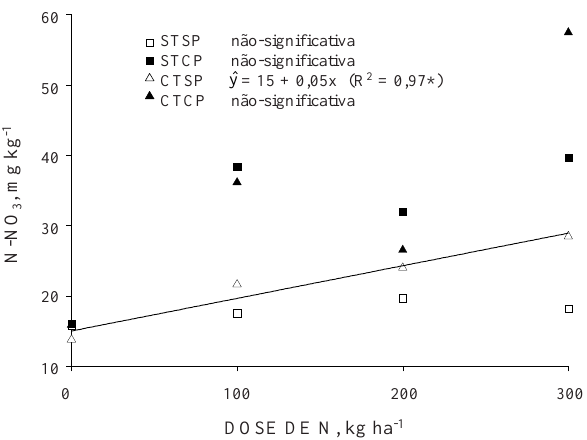
Figura 3. Teores de N-NO 3- no solo de acordo com as doses de N aplicadas no inverno, nas áreas Sem Trevo e Sem Pastejo (STSP), nas áreas Sem Trevo e Com Pastejo (STCP), nas áreas Com Trevo e Sem Pastejo (CTSP) e nas áreas Com Trevo e Com Pastejo (CTCP), Guarapuava (PR) 1999/2000.